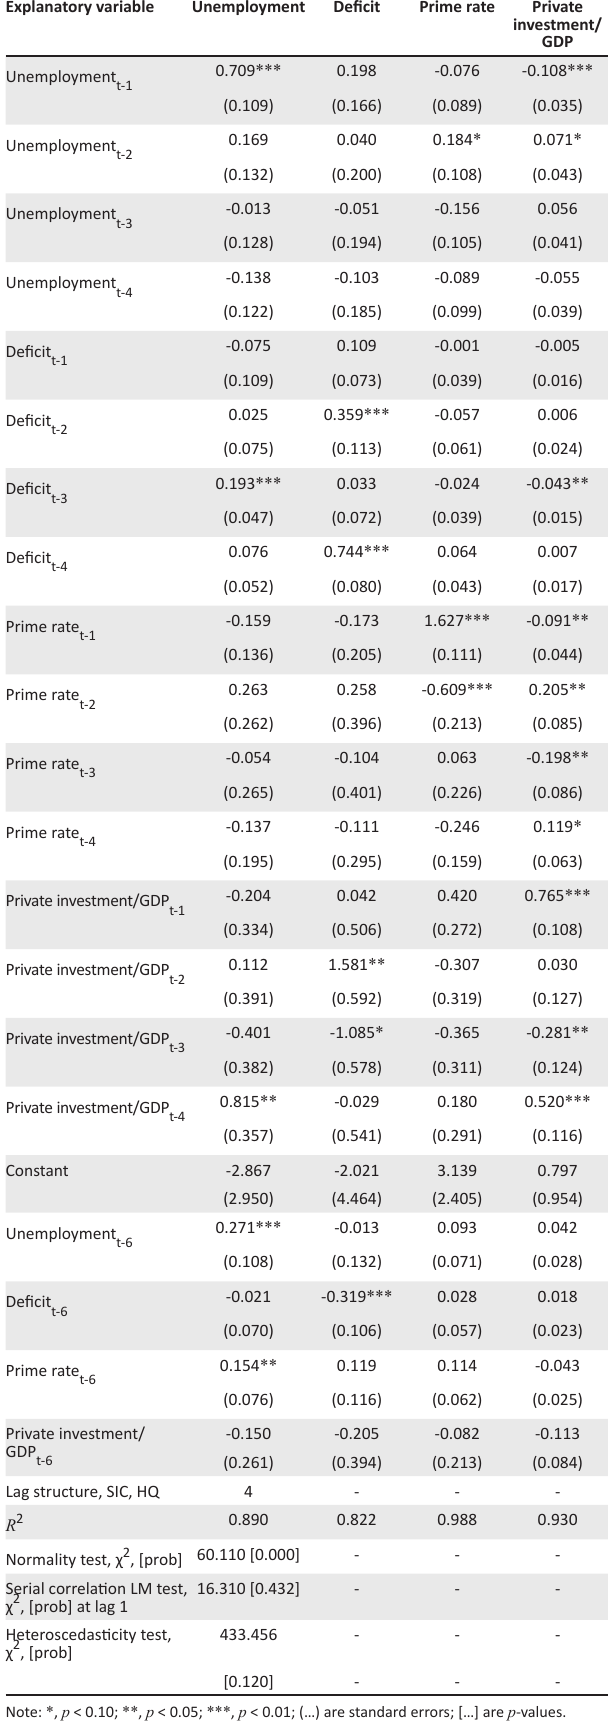
TABLE 2: Toda-Yamamoto vector autoregressive regression estimation